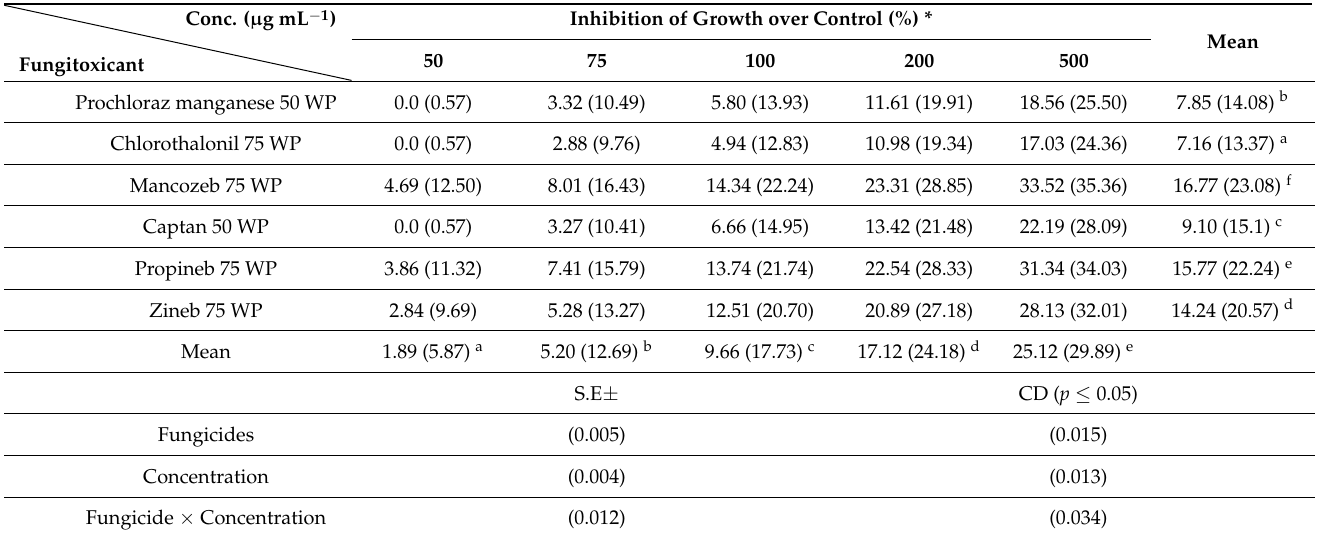
Table 3. Effect of non-systemic fungitoxicants under in vitro conditions on host A. bisporus